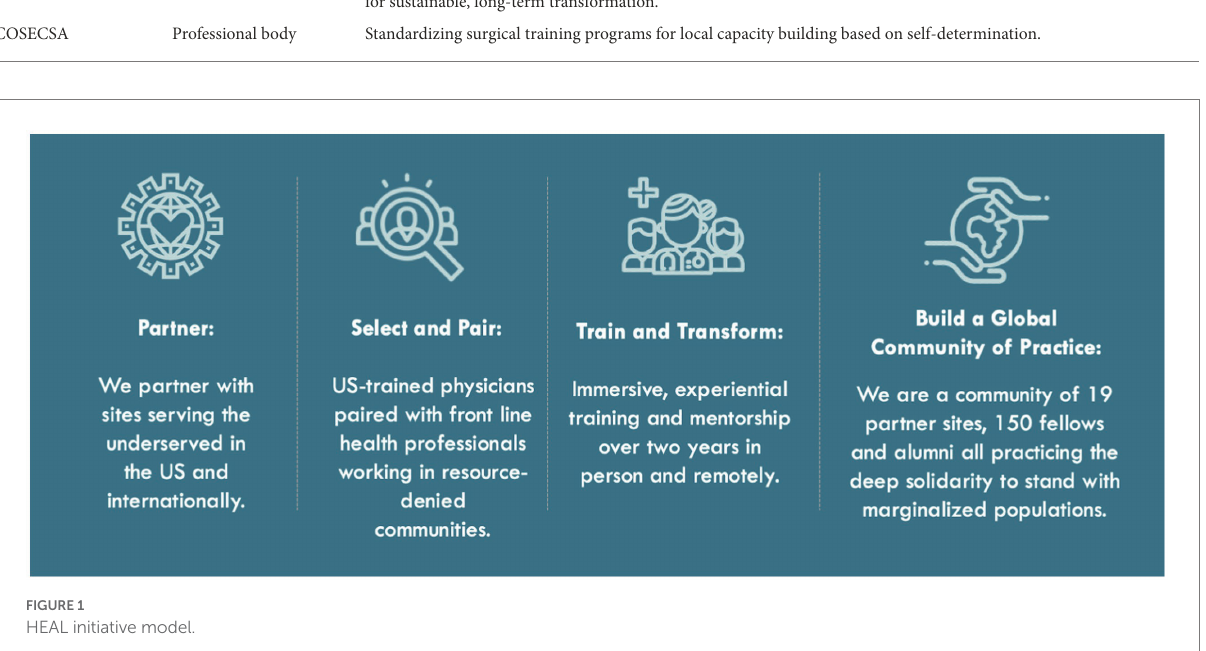
FIGURE 1 HEAL initiative